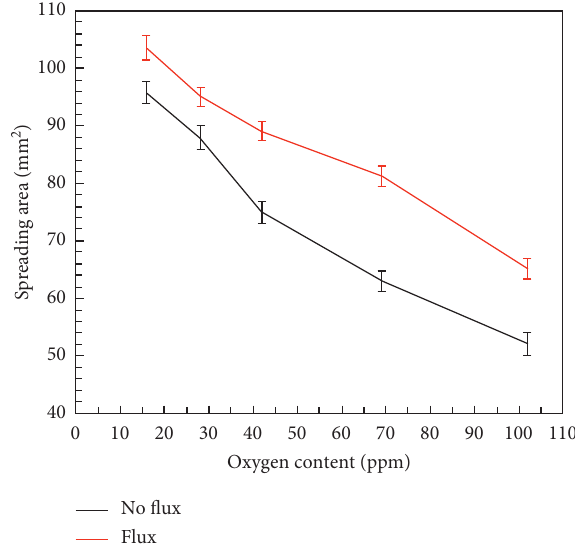
Figure 5: Spreading areas of Au-20Sn solders of 16, 28, 42, 69, and 102 atom ppm oxygen, respectively